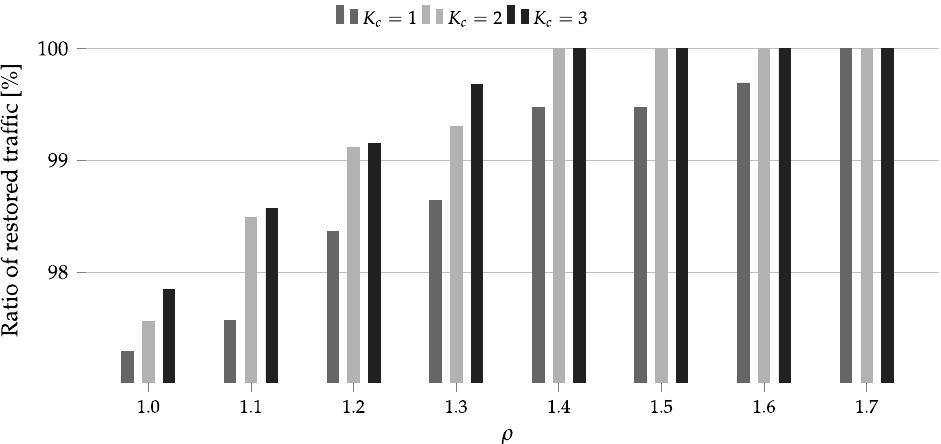
Figure 4. Ratio of the restored traffic for PL12 and 15 Tbps as a function of the amount of additional resources ρ .